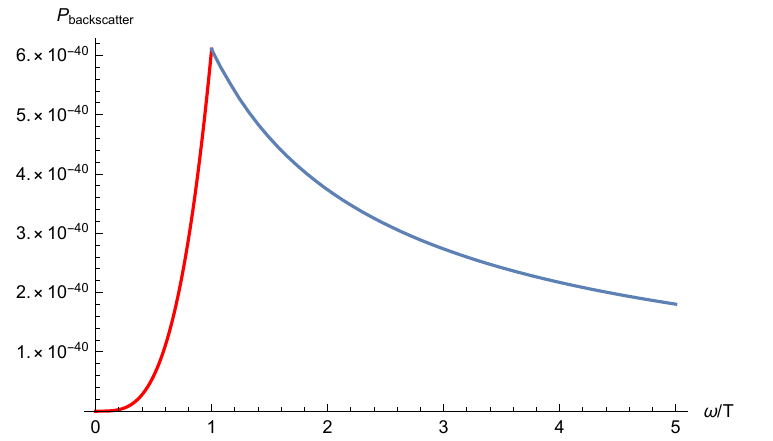
Figure 3 . P backscatter for di(cid:11)erent values of !=T for a solar mass hole. The red line (the left part of the curve) uses the greybody factor expression for !=T (cid:28) 1, while the blue line (right side of the curve) sets the greybody factor to unity, which is appropriate for !=T (cid:29)